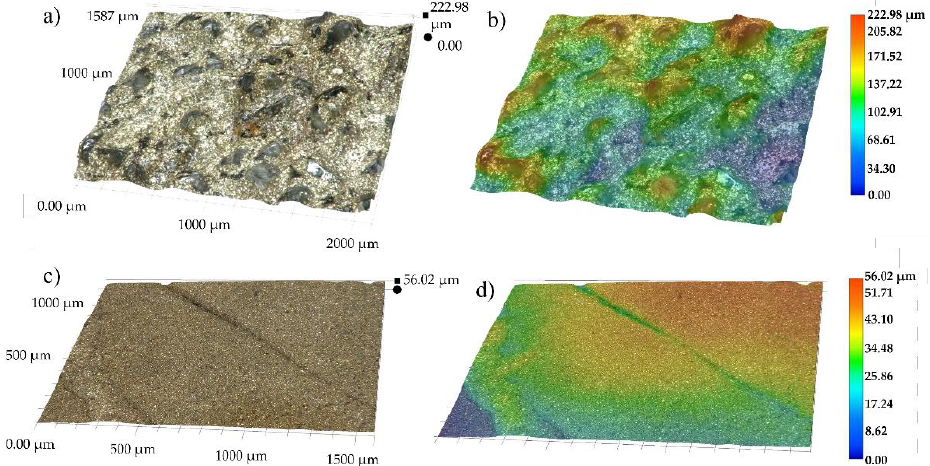
Figure 18. 3D surface topography measurements at mag. 200 × for specimens sintered within ( a ) the refractory ballast with ( b ) color-coded, and ( c ) vacuum-sintered with ( d ) color-coded.